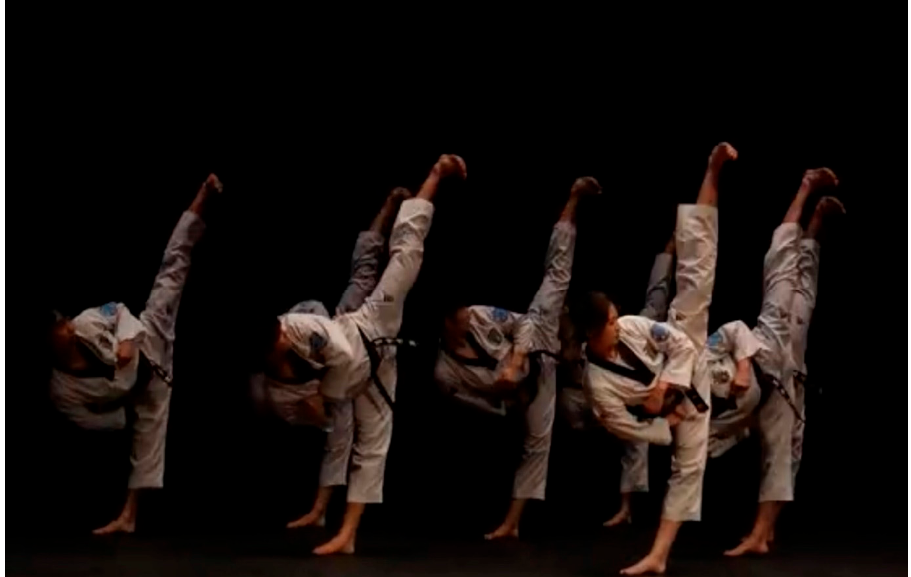
Figure 3. Participants’ side kick demonstration scene in 18 December 2020.